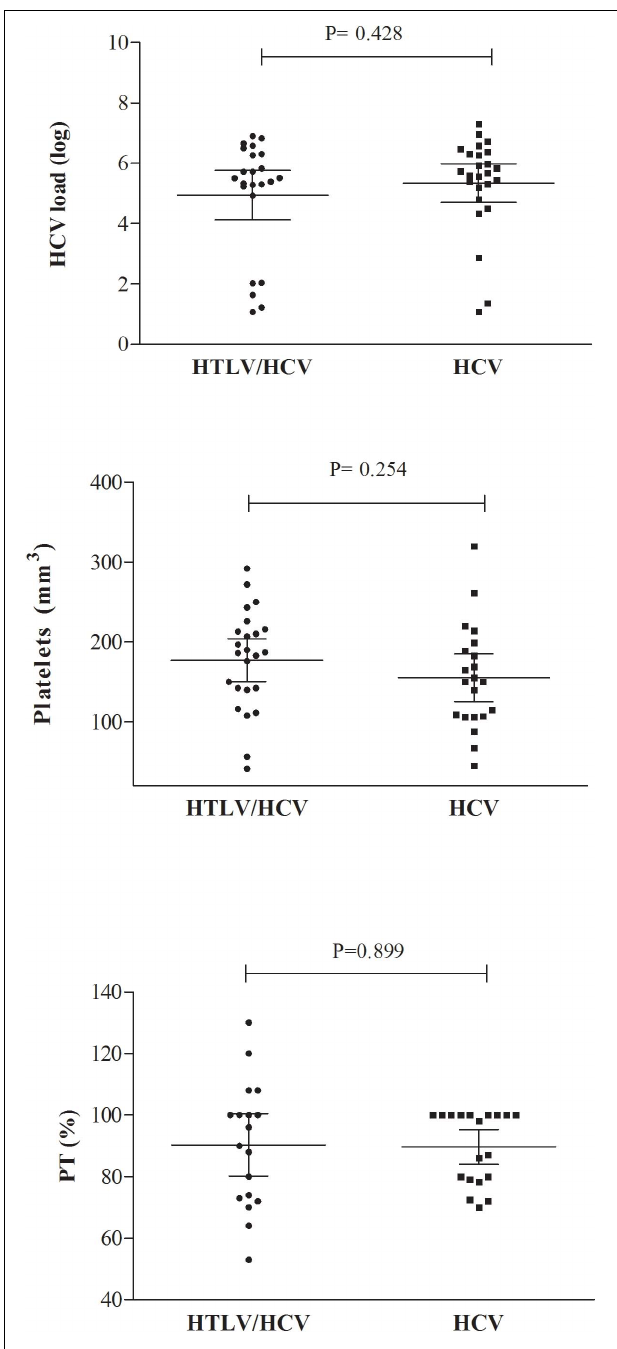
FIGURE 1 | HCV load, platelet count, and prothrombin time (PT) in HTLV/HCV-co-infected and HCV-infected groups.